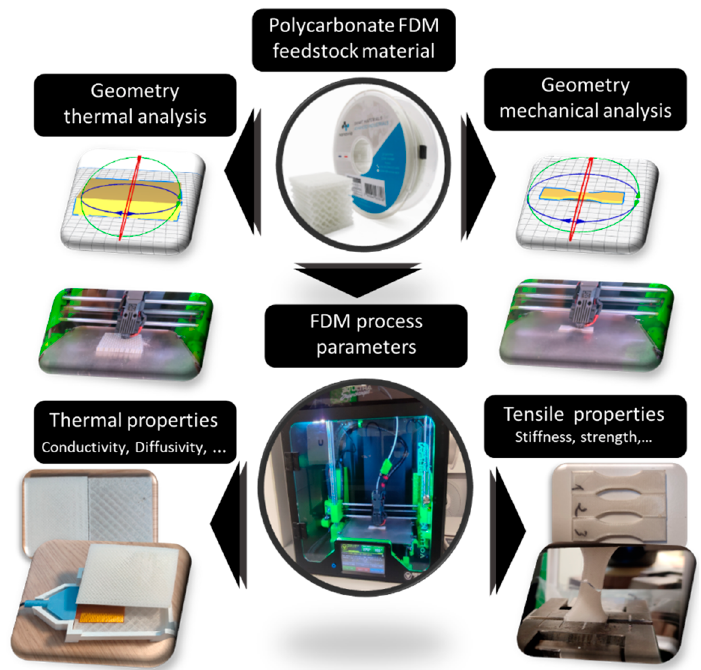
Figure 1. General scheme showing the methodology used to determine mechanical and thermal properties of PC.